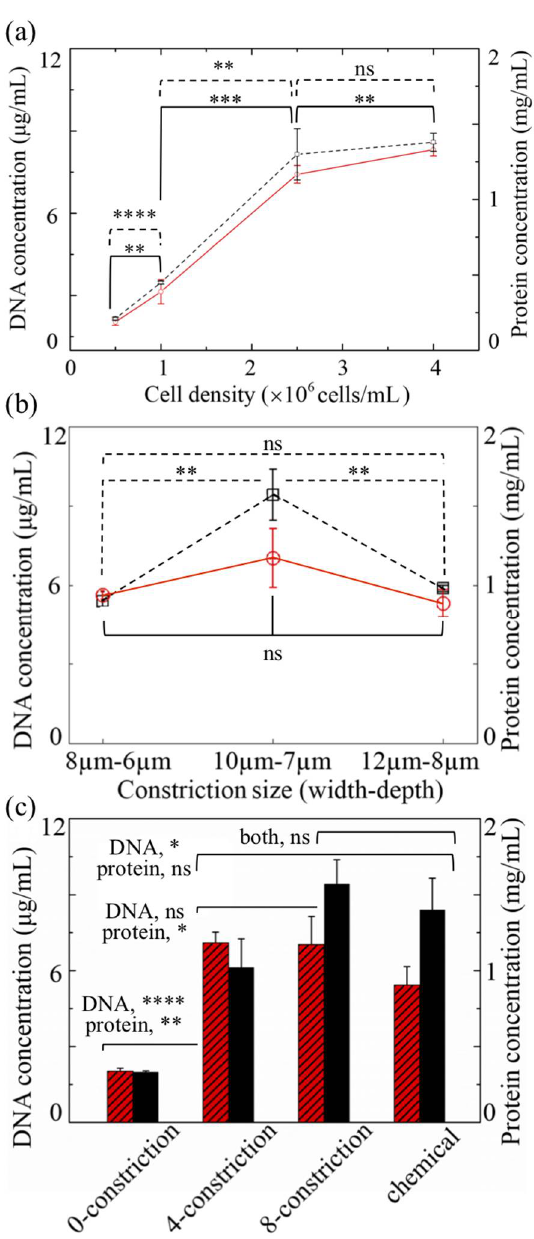
Figure 3. Protein (dashed lines; light-shaded columns) and DNA (solid lines; dark-shaded columns) concentrations of mechanically lysed mouse embryo fibroblast (NIH/3T3) cells obtained by the device as a function of ( a ) the cell population density, ( b ) the constriction size, and ( c ) the number of constrictions per channel. The devices in ( a , b ) feature eight constrictions per channel. Those in ( a , c ) measure w = 10 µ m and d = 7 µ m. The population density in ( b , c ) is 2.5 × 10 6 cells / mL. In ( c ), the controls refer to the lysates obtained from a device without any constriction or from a conventional chemical method. (ns: not significant; ∗ p < 0.05; ∗ ∗ p < 0.01; ∗ ∗ ∗ p < 0.001; ∗ ∗ ∗ ∗ p < 0.0001; two-tailed t -test). Error bars: ± 1 SD ( n = 3 ).